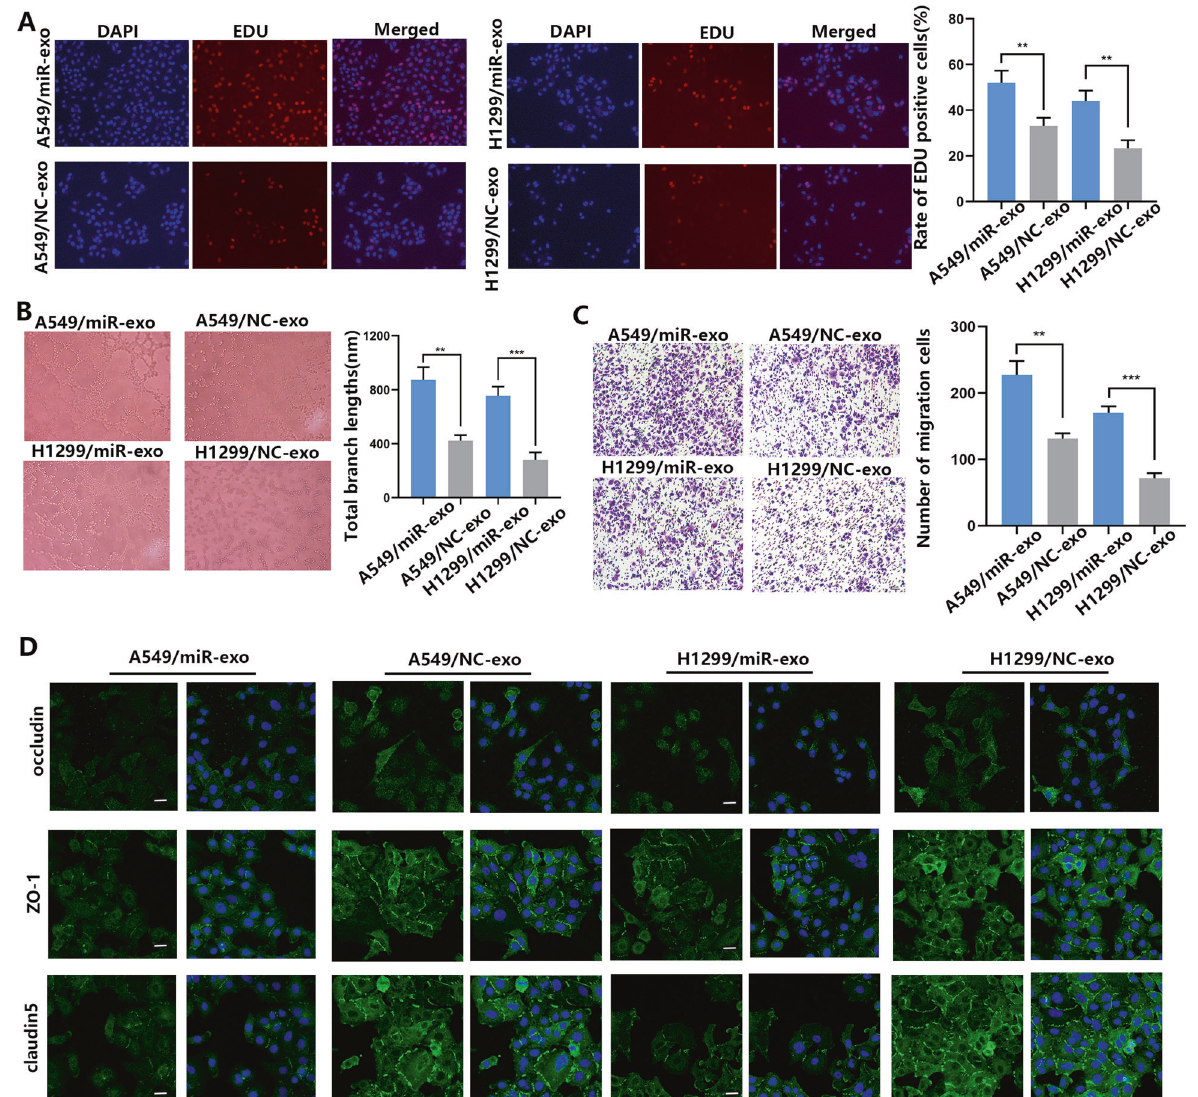
Fig. 5 NSCLC-secreted -miR-3157-3p promotes angiogenesis and vascular leakiness in vitro. A Proliferation of HUVECs co-cultured with A549/miR-3157-3p exosomes, A549/NC exosomes, H1299/miR-3157-3p exosomes, H1299/NC exosomes (× 400). B Effects of HUVECs co- cultured with A549/miR-3157-3p exosomes, A549/NC exosomes, H1299/miR-3157-3p exosomes, H1299/NC exosomes on tube formation (x100). C Effects of HUVECs co-cultured with A549/miR-3157-3p exosomes, A549/NC exosomes, H1299/miR-3157-3p exosomes, H1299/NC exosomes on migration (×100). D Immuno fl uorescence staining analysis of ZO-1, occludin, Claudin5 expression in HUVECs co-cultured with A549/miR-3157-3p exosomes, A549/NC exosomes, H1299/miR-3157-3p exosomes, H1299/NC exosomes. Scale bar, 20 μ m. The data are shown as the mean ± SD ( ** P < 0.01; *** P <